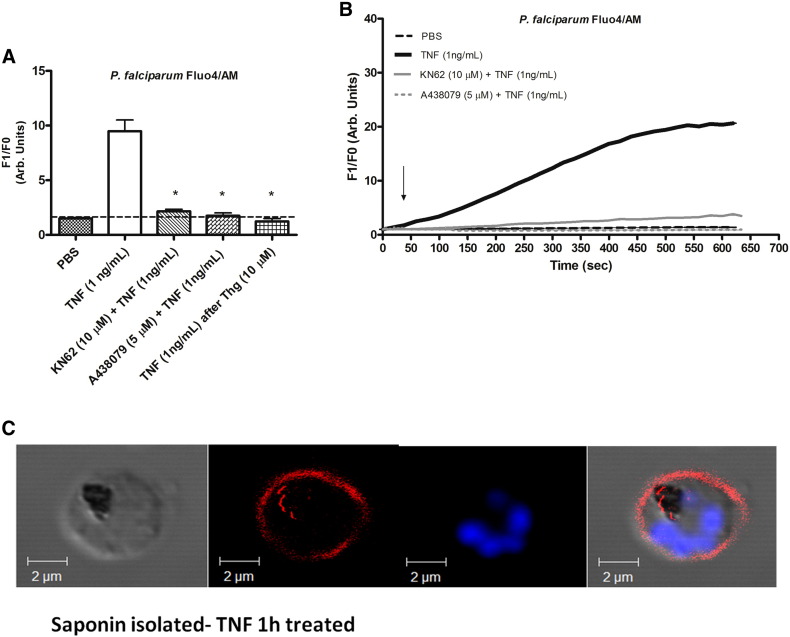
TNF intracellular calcium signalling can be blocked by P2X7 antagonist in P. falciparum isolated parasites labelled with Fluo4/AM (5 μM). (A) Analyses of Ca2 + concentration after incubation with the purinergic inhibitor KN62 (10 μM) for 30 min, A438079 (5 μM) for 2 min or thapsigargin (10 μM) all followed by addition of TNF (1 ng/ml) (2.15 a.u. ± 0.19, n = 13, P < 0.0001; 1.76 a.u. ± 0.24, n = 11, P < 0.0001; or 1.236 a.u. ± 0.25; n = 11, P < 0.0001, respectively). P values were calculated by comparison with the TNF (1 ng/ml) data (9.746 a.u. ± 1.03, n = 15). Bar graph means and SEM of at least three independent experiments. Arb. arbitrary. (B) Representative tracing of Fluo4/AM changes over time by addition of PBS, TNF (1 ng/ml) and TNF (1 ng/ml) after incubation with KN62 (10 μM) or A438079 (5 μM) (C) Imaging of wheat germ agglutinin (WGA) staining in P. falciparum (3D7) saponin isolated parasite after TNF (1 ng/ml) treatment for 1 h at 37 °C. Smears are stained with WGA (10 μg/ml for 10 min at 37 °C) and DAPI (1:1000 in PBS 15 min at RT) and observed by confocal microscopy.